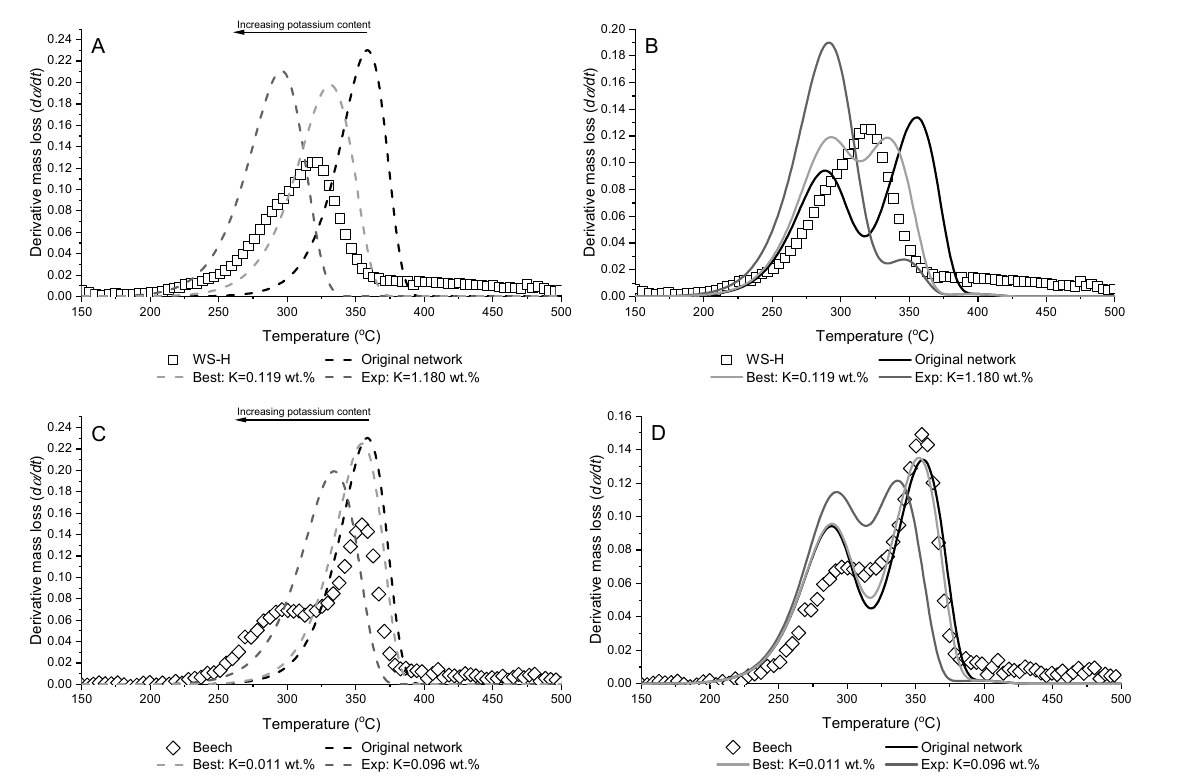
Figure 8. Comparison of the experimental derivative degradation curves with the predictions of the R17a model [21] modified using the Trendewicz model [26] assuming three different potassium contents: ( A ) cellulose curves against WS-H experimental degradation; ( B ) summative curves against WS-H experimental degradation; ( C ) cellulose curves against beech experimental degradation; and ( D ) summative curves against beech experimental degradation.